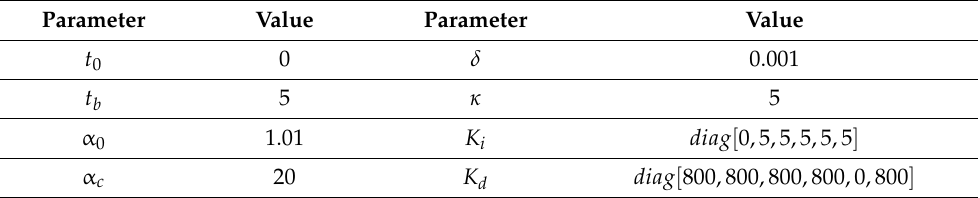
Table 4. Controller parameters for simulation of a desired spiral